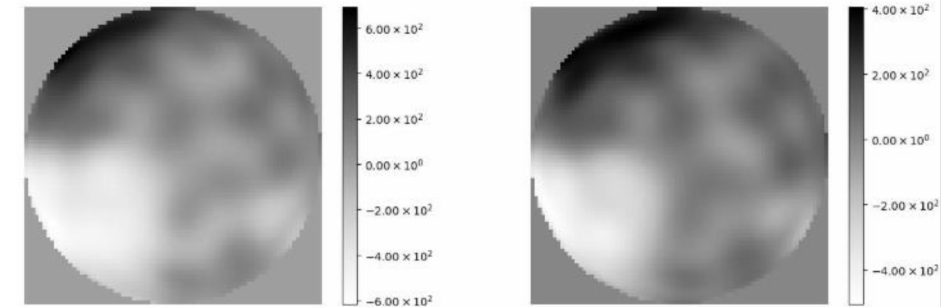
Figure 5. Comparison of a sample of the test set with r 0 of 12 cm for the MLP model. On the left, the original reconstructed turbulence phase and, on the right, the one reconstructed with the Zernike’s coefficients obtained by the MLP. Despite the error in the numerical values, with a naked eye both phases’ profiles are very